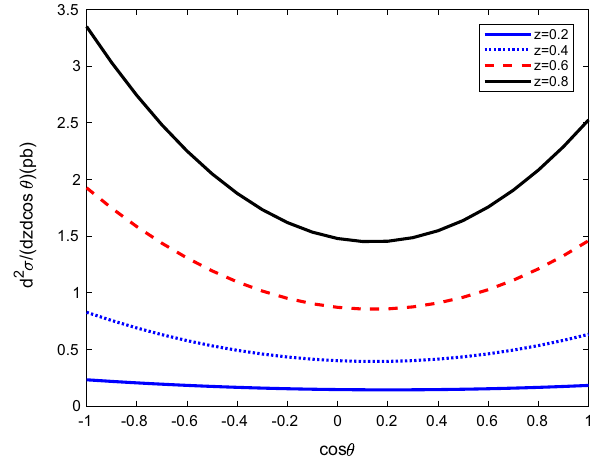
Fig. 2 The differential cross section d 2 σ/( dz d cos θ) for the produc- tion of the B ∗ c ( 1 3 S 1 ) meson at the Z pole under the fragmentation- function approach up to NLO+NLL level, where θ is the angle between the momenta of the final B ∗ c meson and the initial electron